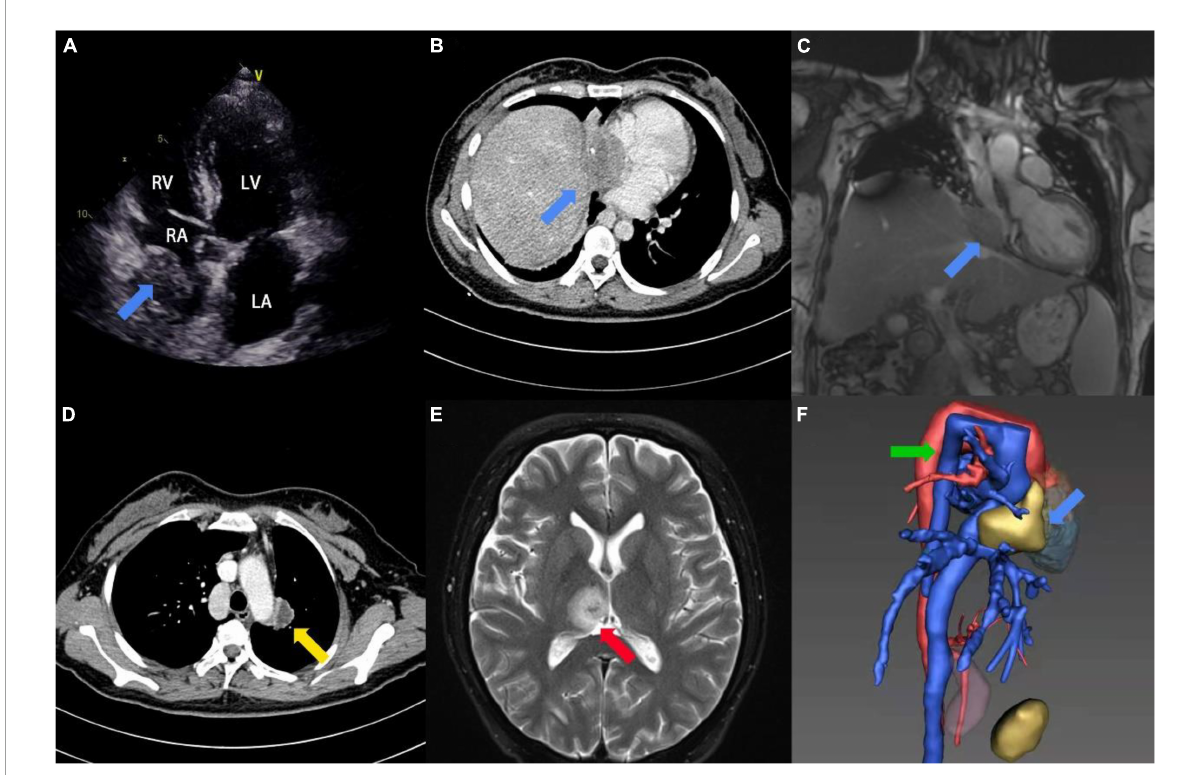
FIGURE1 Image findings. (A) Preoperative 2D-TTE four-chamber view showed an irregular mass (blue arrow) within the right atrium. (B) Preoperative CTA showed a mass with slight calcification (blue arrow) within the right atrium and IVC. (C) Preoperative MRI showed a hypointense mass (blue arrow) at the junction of the right atrium and IVC on coronary-reconstruction view. (D) Preoperative CTA showed a lesion with slight enhancement in the left lung (yellow arrow). (E) Preoperative MRI showed an oval hypertense lesion (red arrow) within the brain on T2-weighted image. (F) 3D-reconstruction view of preoperative CTA showed the cardiac mass (blue arrow) and enlarged azygos vein (green